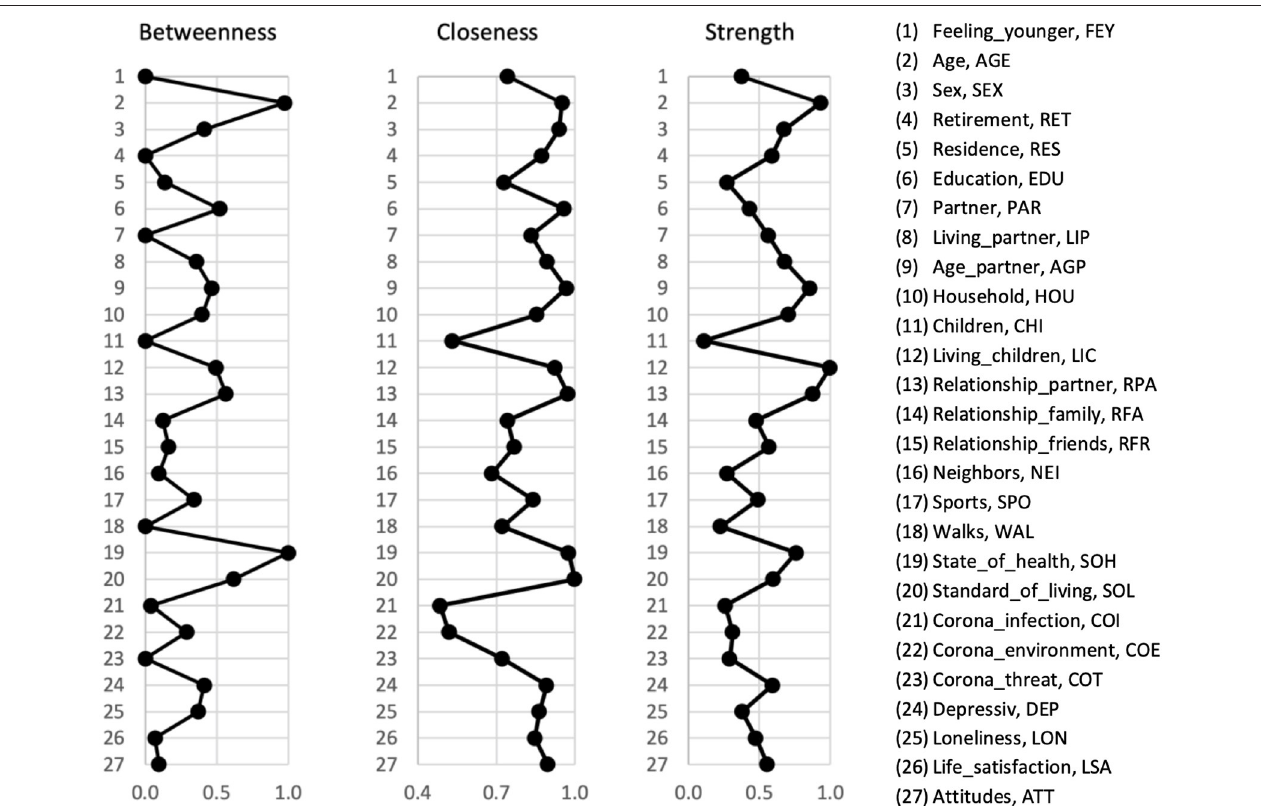
FIGURE 2 | Node centrality of the total study population. Centrality indices for betweenness, closeness, and strength are given in relative values. A higher centrality measures indicate that the node is more central to the network.